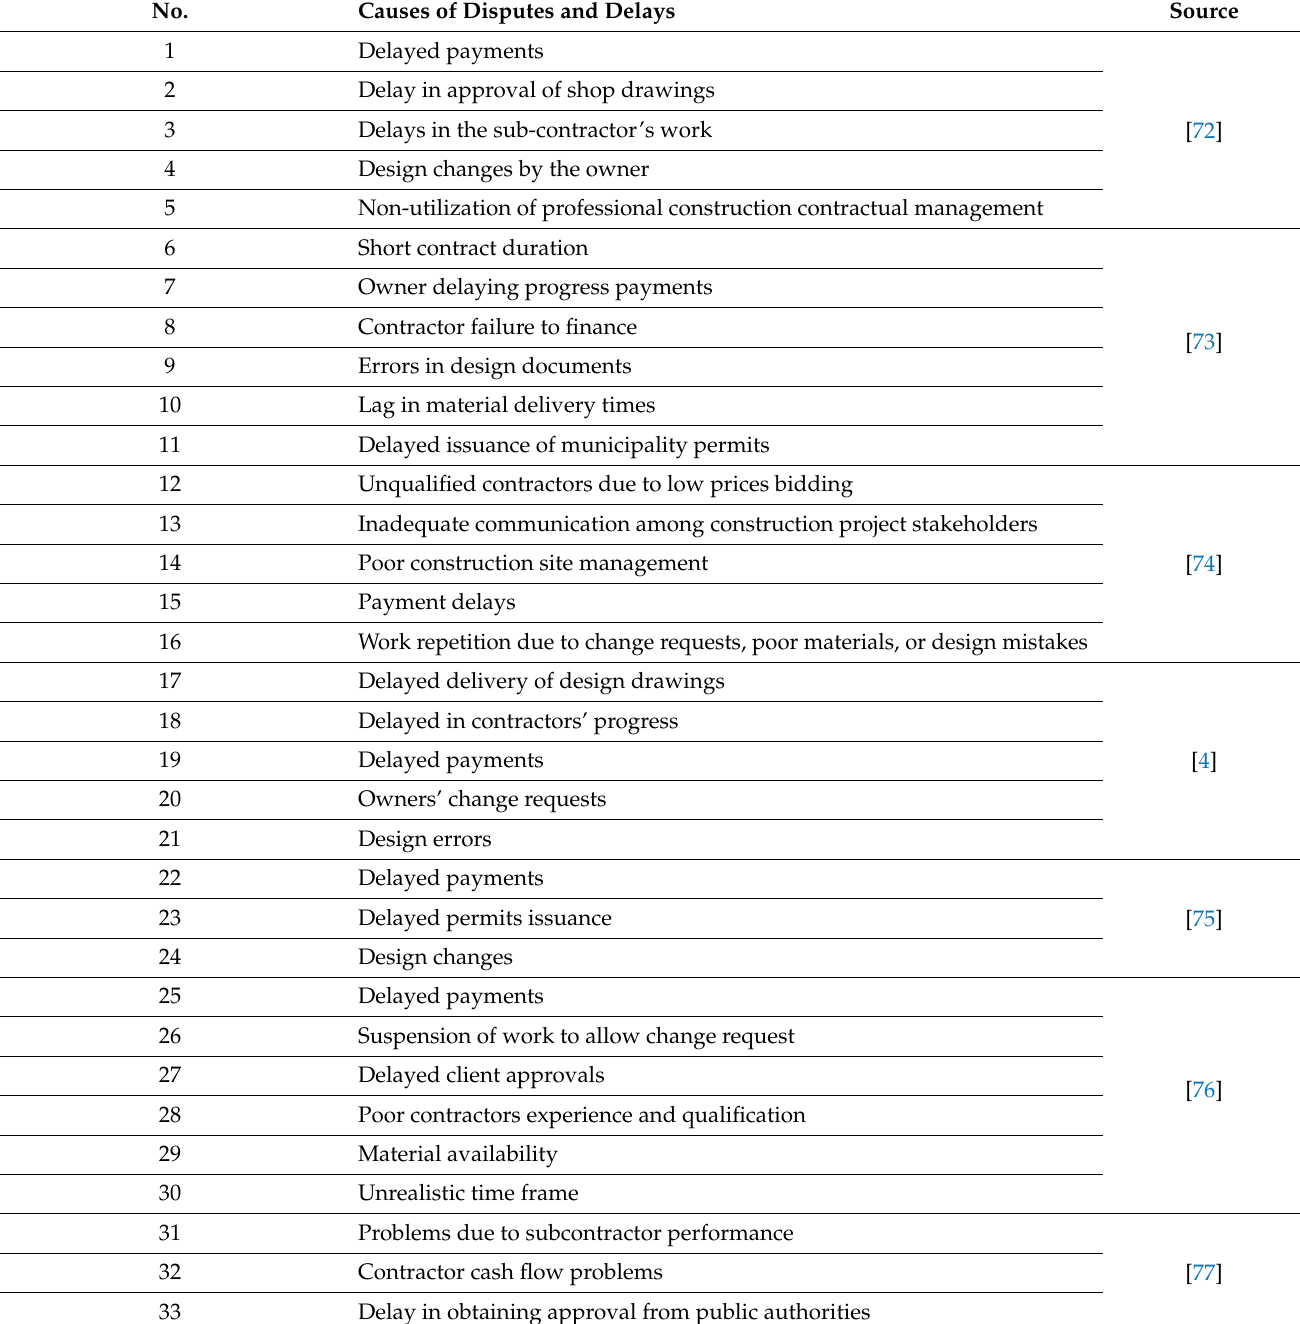
Table 3. Major reasons of disputes and